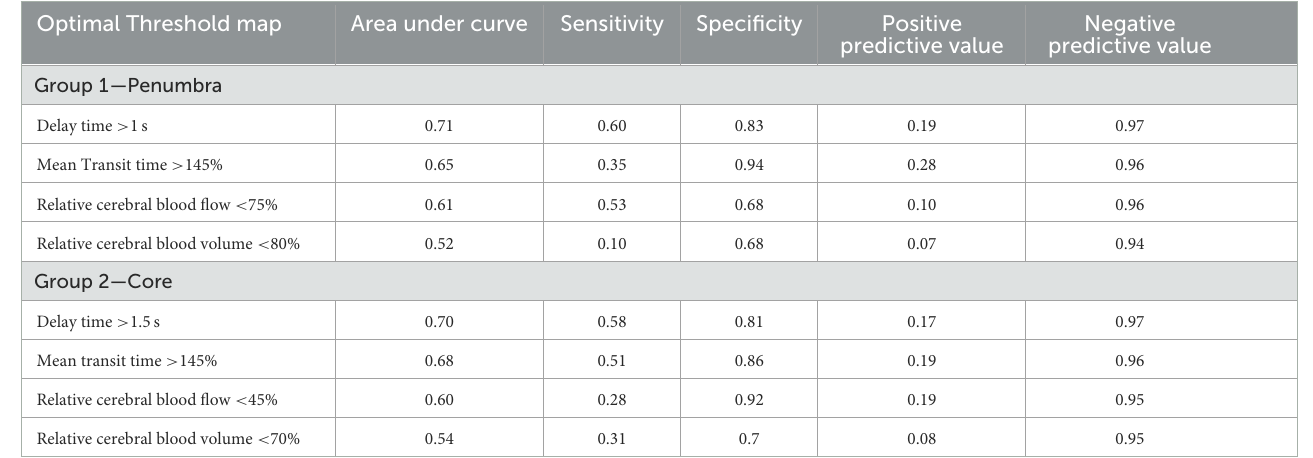
Negative predictive value predictive